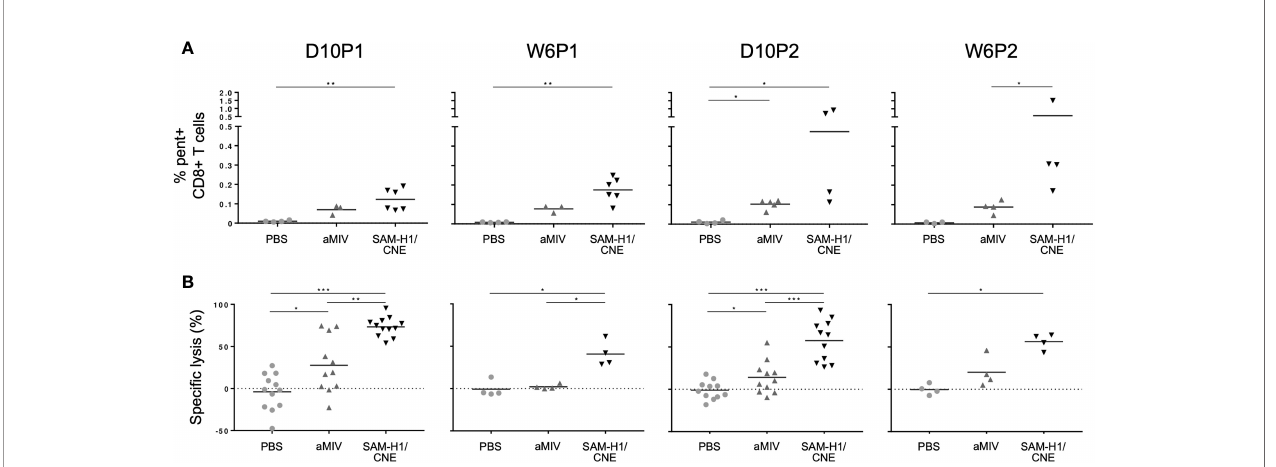
FIGURE 1 | SAM-H1/CNE elicits pent+CD8+ T cells associated with cytotoxic activity in vivo . (A) Frequency of pent+CD8+ T cells in mice immunized with SAM-H1/ CNE (black), aMIV (dark grey) or PBS (light grey). (B) In vivo lysis of adoptively transferred splenocytes loaded with HA 533-541 or control HIV gag 199-207 peptides. The